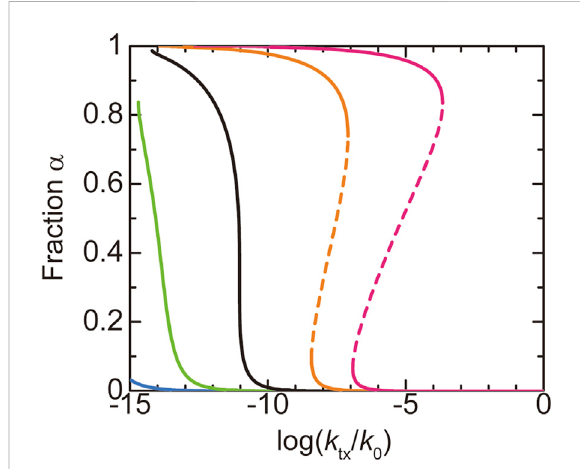
The fraction α of A blocks in the shell of a paraspeckle is shown as a function of the (natural) logarithm of the transcription rate k tx for N A = 1.0 (cyan), 3.0 (light green), 5.2483 (black), 8.0 (orange), and 10.0 (magenta). The values of parameters used for the calculations are N B = 40.0, N C = 15.0, χ B = 0.5, χ AB = 1.0, v